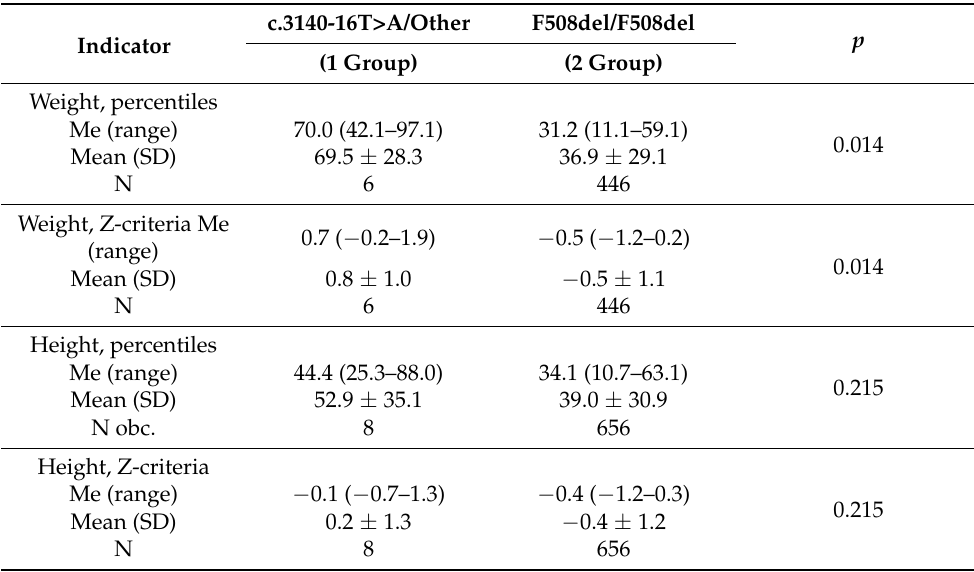
Table 3. Indicators of body weight and height (percentiles and Z-criteria) in patients with cystic fibrosis with different genotypes in